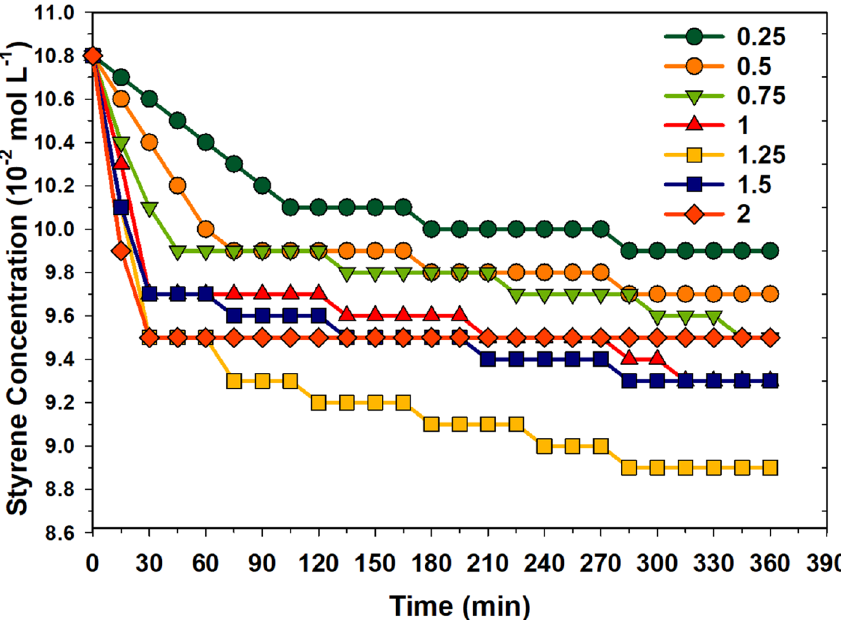
Figure 3. Change in styrene concentration at various H 2 O 2 concentrations (10 –2 mol L −1 ) as a function of time under UV radiation at STP conditions (without catalyst complexes). Reaction conditions: styrene: 10 mmol L –1 ; acetonitrile: 50